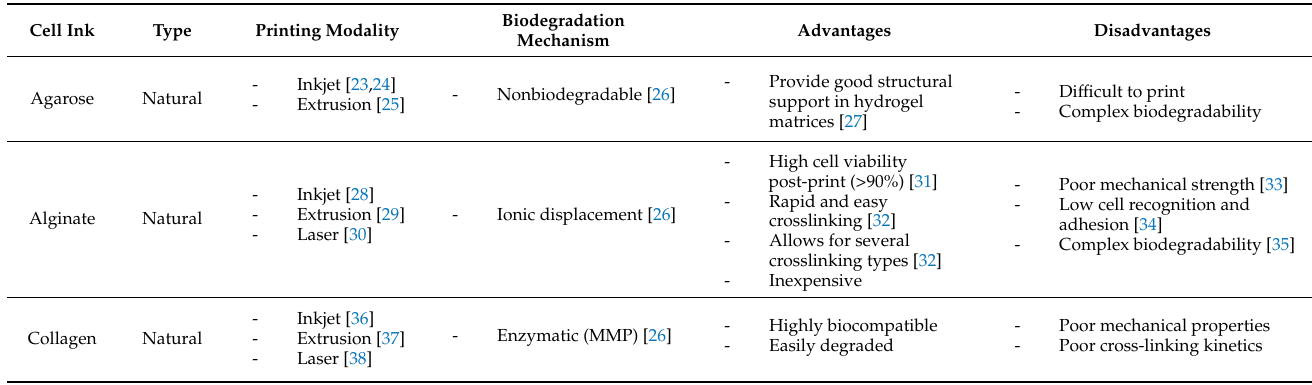
Table 1. An assortment of polymeric hydrogels commonly used in cell inks for